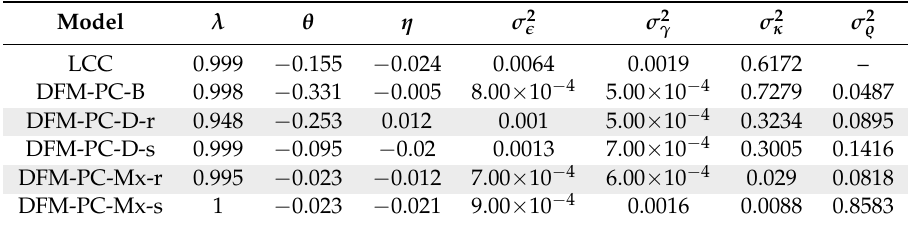
(cid:16) λ , θ , η , σ 2 (cid:101) , σ 2 γ , σ 2 κ , σ 2 (cid:36)